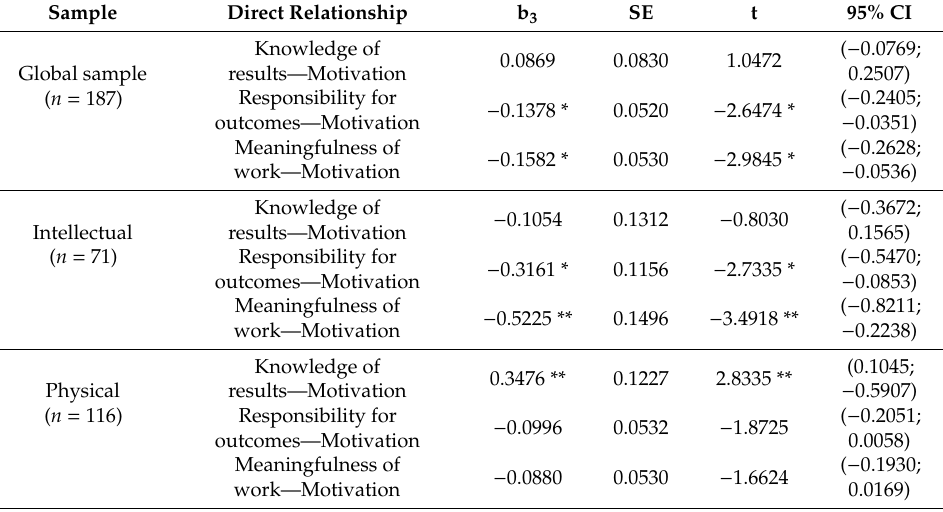
Table 4. Analyses of the moderator e ff ect of self-e ffi